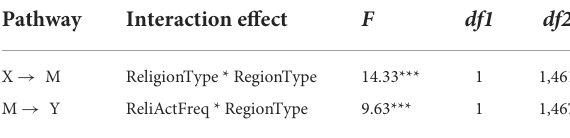
TABLE 7 Interaction effects of moderated mediation model.